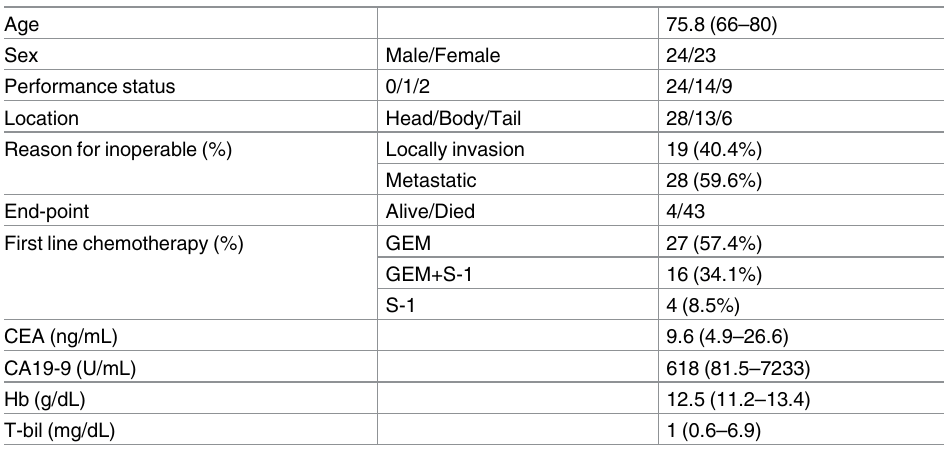
Table 1. Patients